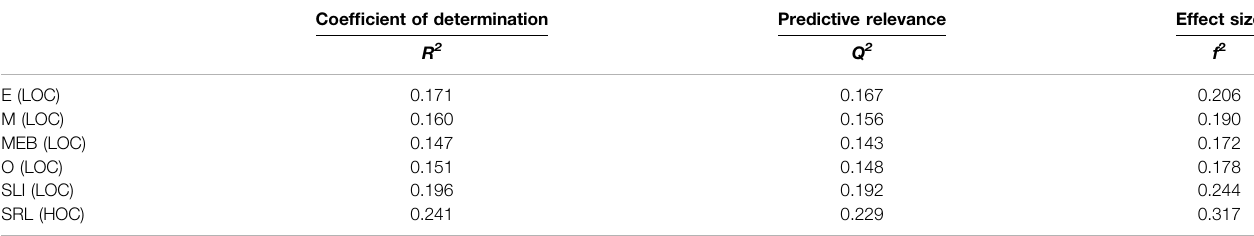
TABLE 7 | Coef fi cient of Determination ( R 2 ), Predictive Relevance ( Q 2 ), and Effect size ( f 2 ). Coef fi cient of